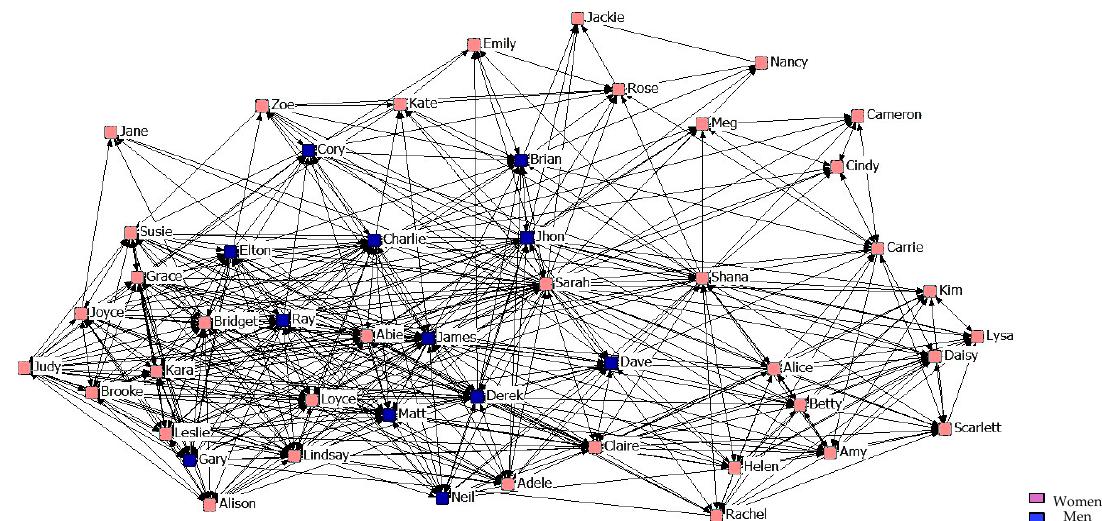
Figure 5. Graph of the first year Intermediate Friendship Network.